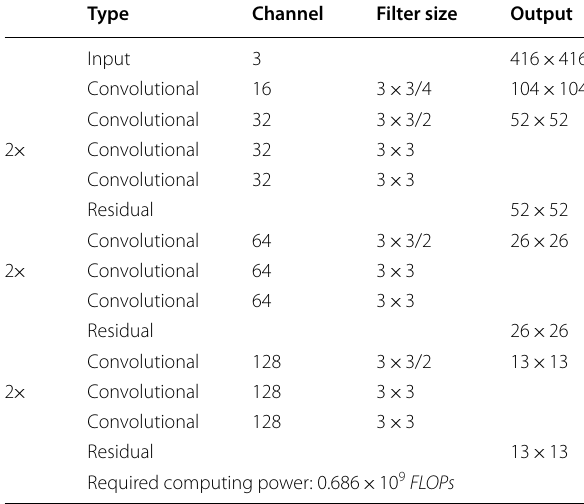
Table 1 Feature extraction network